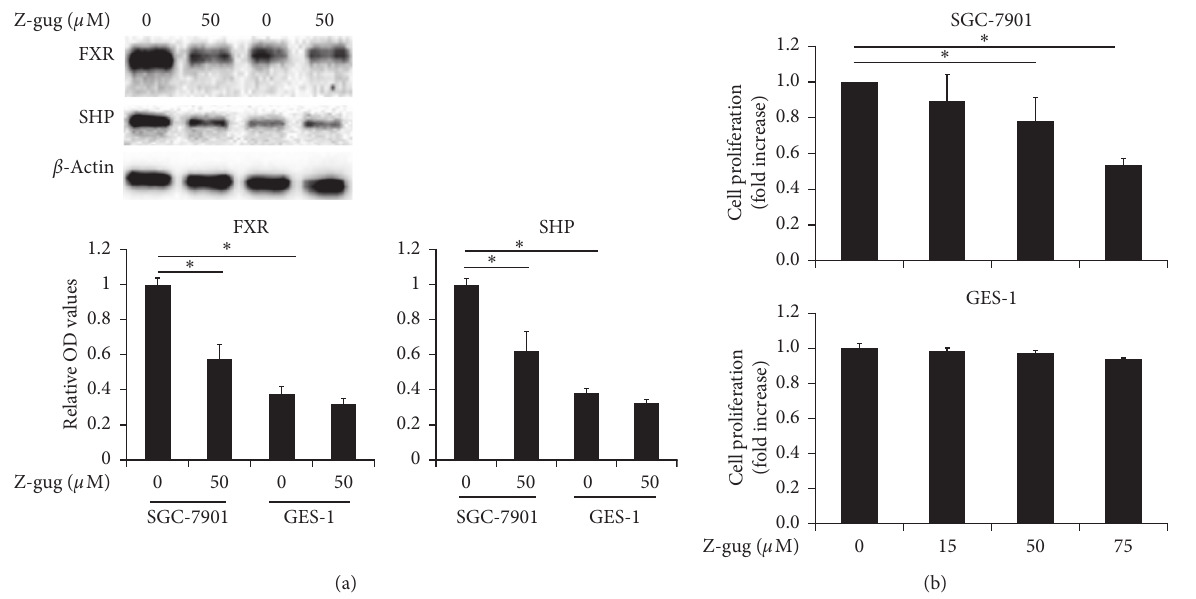
Figure 1: Z-guggulsterone, an FXR antagonist, exhibited cytotoxicity in SGC-7901 cells. (a) Cells were incubated with 0 and 50 µ M z- guggulsterone. FXR and SHP protein levels were assessed by western blotting. Quantification of protein bands are shown in the bottom panels. β -Actin was used as a control. Data are expressed as means ± SD. ∗ p < 0 . 05 vs. untreated cells. (b) Cells were incubated with 0, 15, 50, and 75 μ M z-guggulsterone, and cell survival was investigated using MTTassay. Data are expressed as means ± SD. ∗ p < 0 . 05 vs. untreated cells. Z-gug, z-guggulsterone.